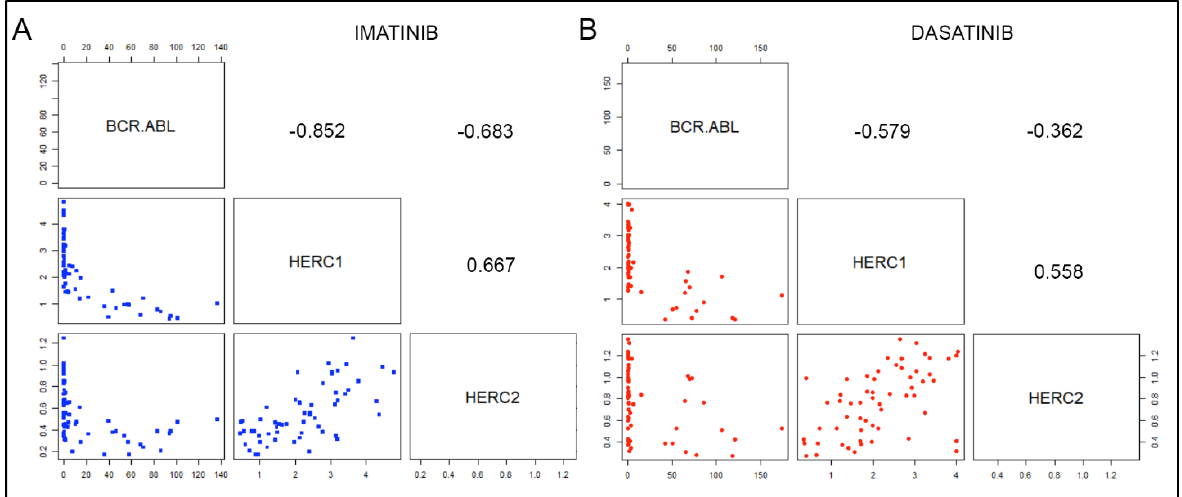
Figure 3. Gene expression correlation analyses among HERC1 , HERC2, and BCR-ABL from CML patients treated with two different TKIs. The scatter plots and Spearman coefficient (rho) showed the correlations occurring among the BCR - ABL , HERC1, and HERC2 transcripts in CML patients’ specimens collected at different time points starting from the beginning of the Imatinib ( A ) and Dasatinib ( B ) treatments up to 12 months (0, 3, 6, and 12). Values are expressed either as 2 −∆∆ Ct for both HERC1 and HERC2 and as I.S. for BCR - ABL , respectively. Each blue and red solid circle refers to a patient who has been treated either with Imatinib or with Dasatinib, respectively.